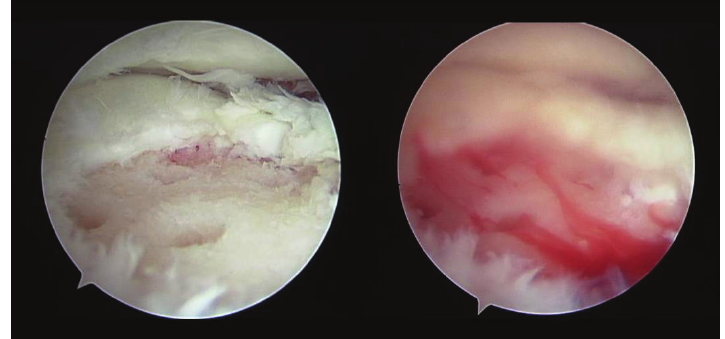
Figure 5: Arthroscopic findings: good hemorrhage from within the bone marrow was confirmed after the tourniquet was